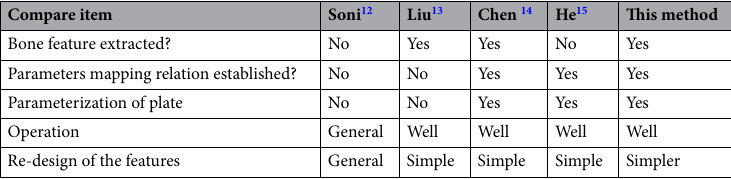
Table 3. Comparison between the proposed method and existing